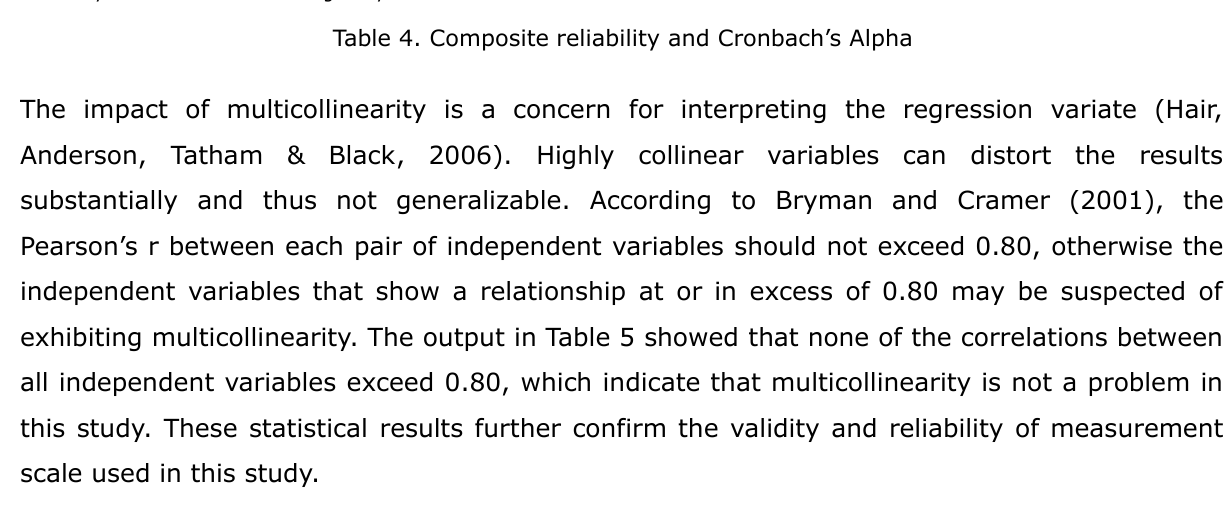
Table 4. Composite reliability and Cronbach’s Alpha